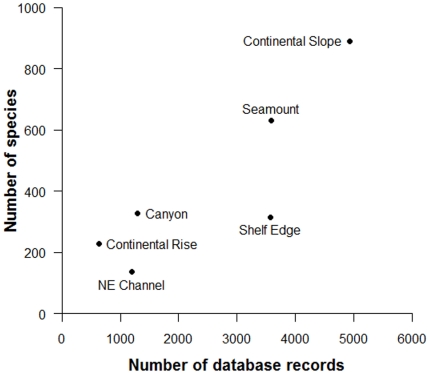
The number of database records in relation to known species.Positive correlation (Pearson's r = 0.86, p<0.025) between the number of records compiled within the deep-sea database (representing the number of times a sub-region has been sampled, used as a proxy for sampling effort) and the number of known species within each sub-region.